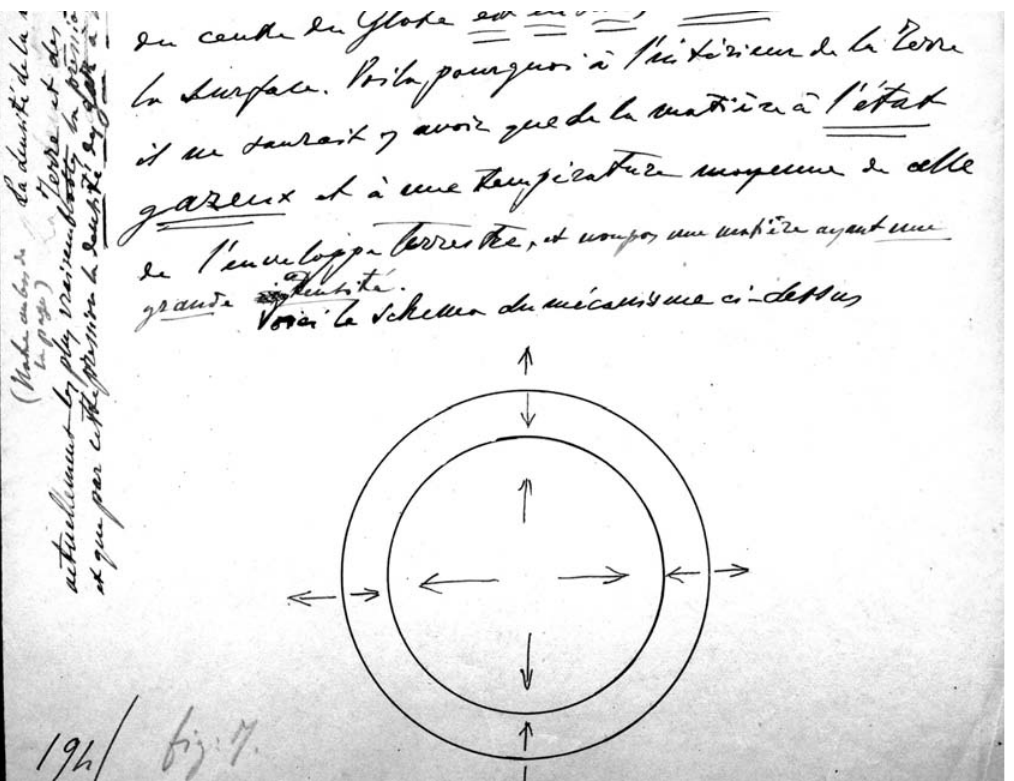
Fig. 9. The sketch of the mechanism of the planetary expansion by the pressure of the inner Earth’s material in a high temperature gasiform-state (manuscript Dilatation planétaire of